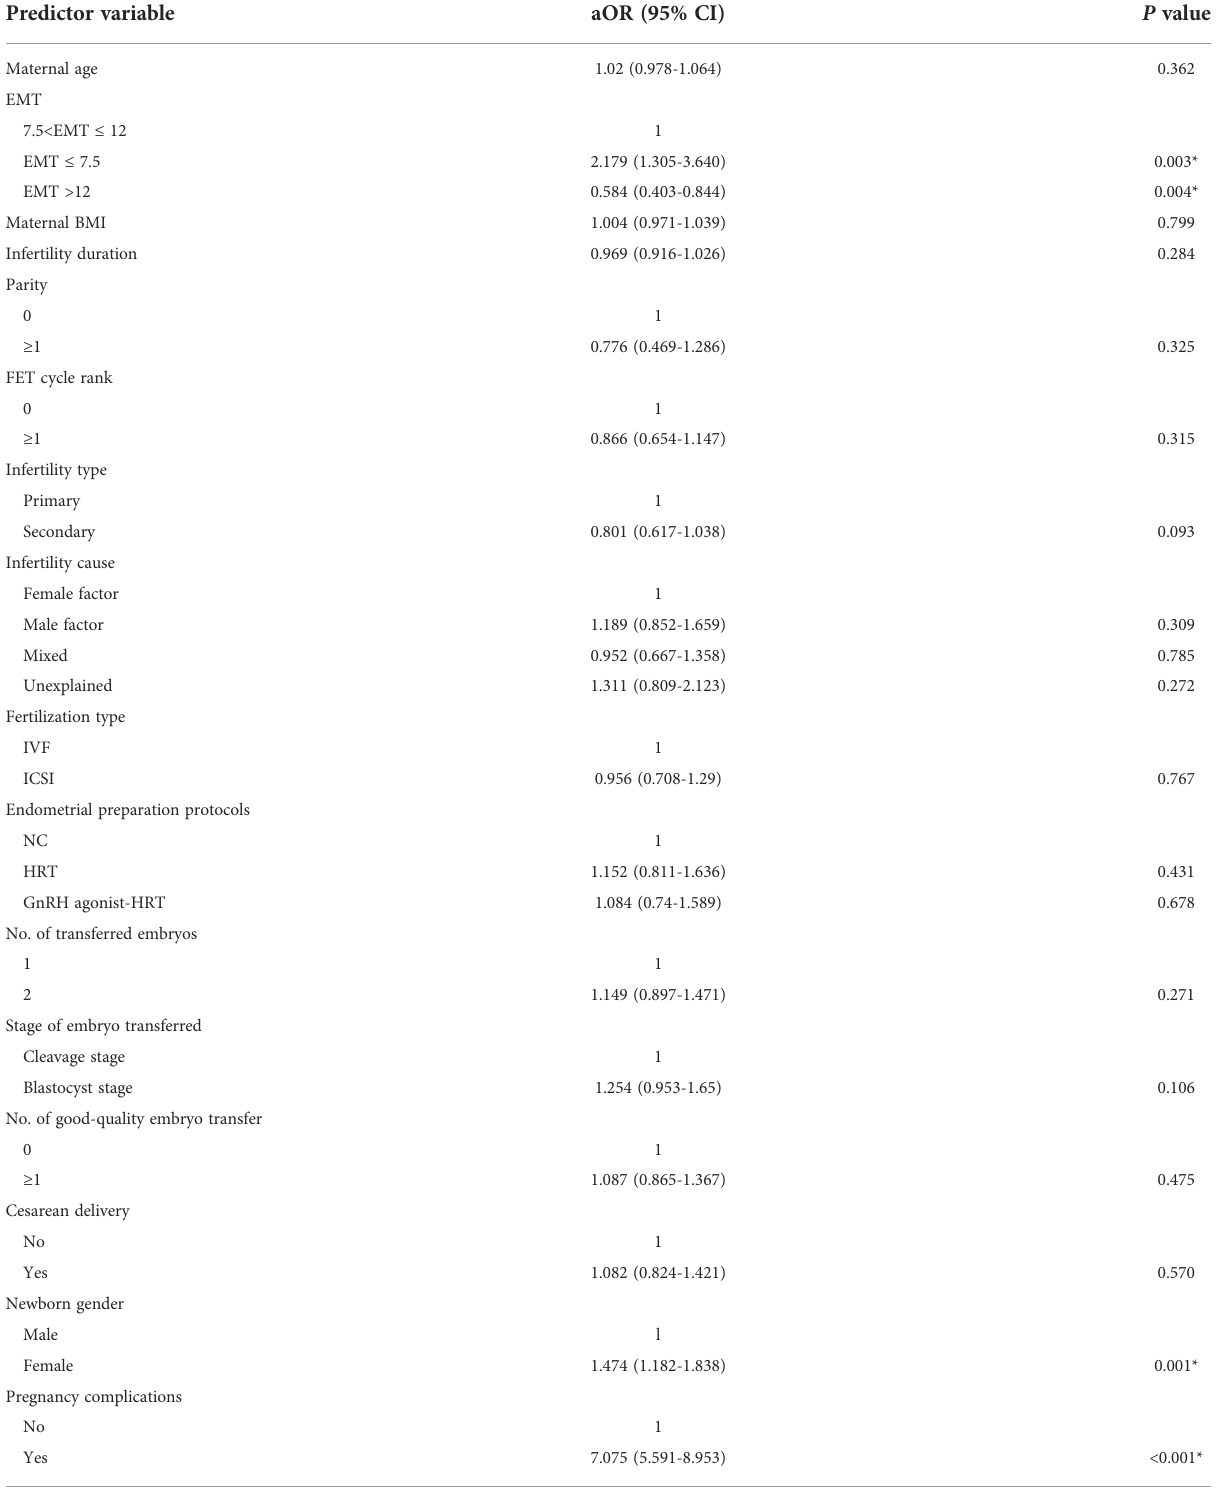
TABLE 4 Adjusted odds ratios of LBW by multivariate analysis of predictor